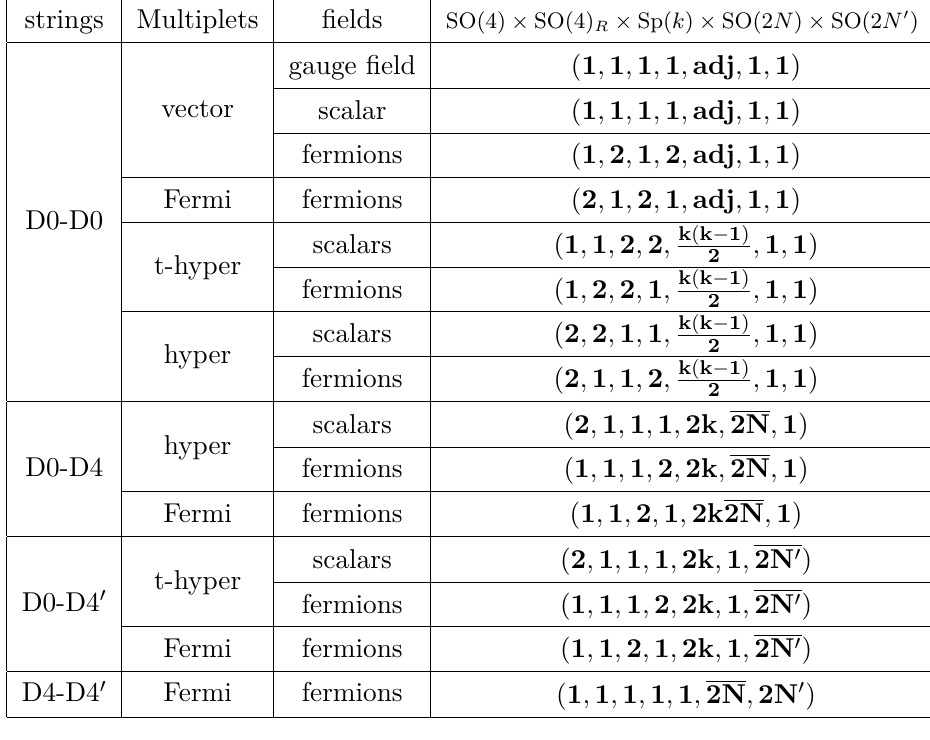
Table 4 . The field content of the quantum mechanics. Sp( k ) = b G is the D0 brane group, SO(2 N ) = G is the D4 brane group and SO(2 N 0 ) = G 0 is the D 4 0 brane group. SO(4) = SU(2) − × SU(2) + , SO(4) R = SU(2) R × SU(2) R . Of interest to us is the case of a single D 4 0 brane, N 0 = 1 . t-hyper − + denotes a (0 , 4) twisted